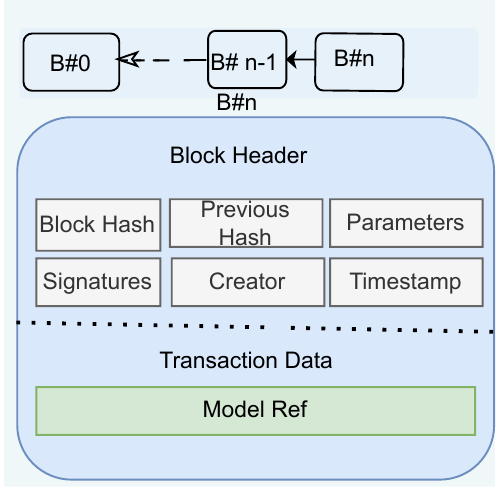
Figure 3. Customized structure of Block used in